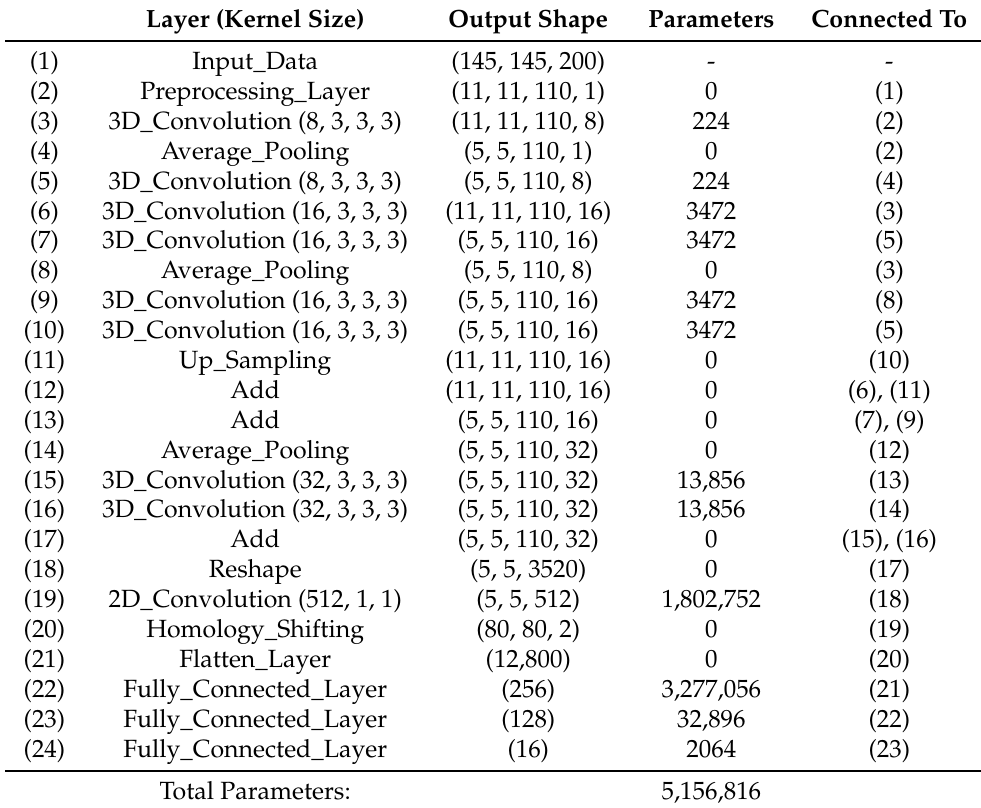
Table 5. Network architecture details of Oct-MCNN-HS for the Indian Pines